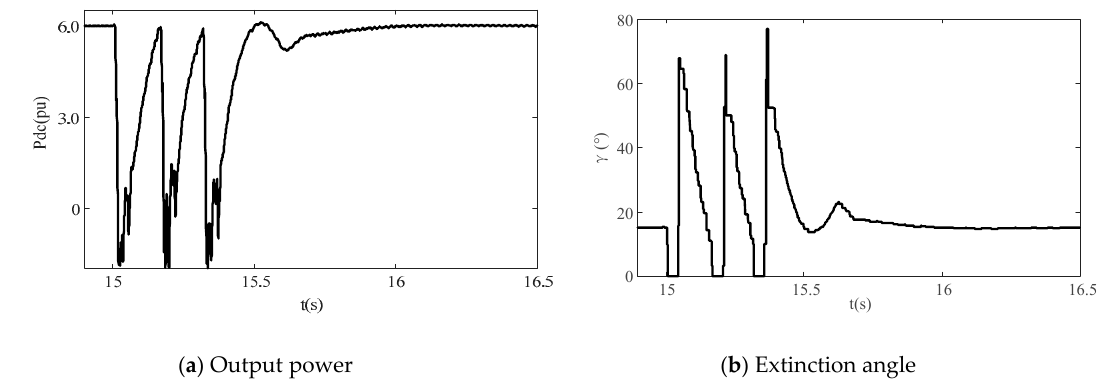
Figure 12. Operation characteristic of DC 1 under continuous CFs.